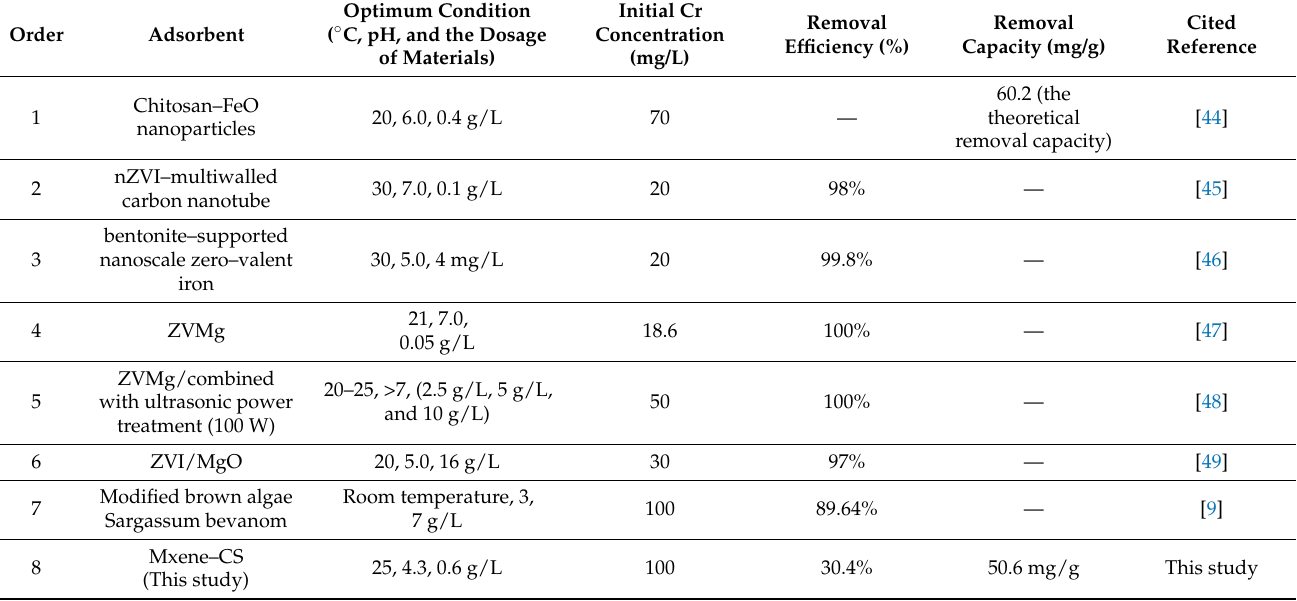
Table 4. Comparasion for removal of Cr(VI) through different materials from an aqeous solution.